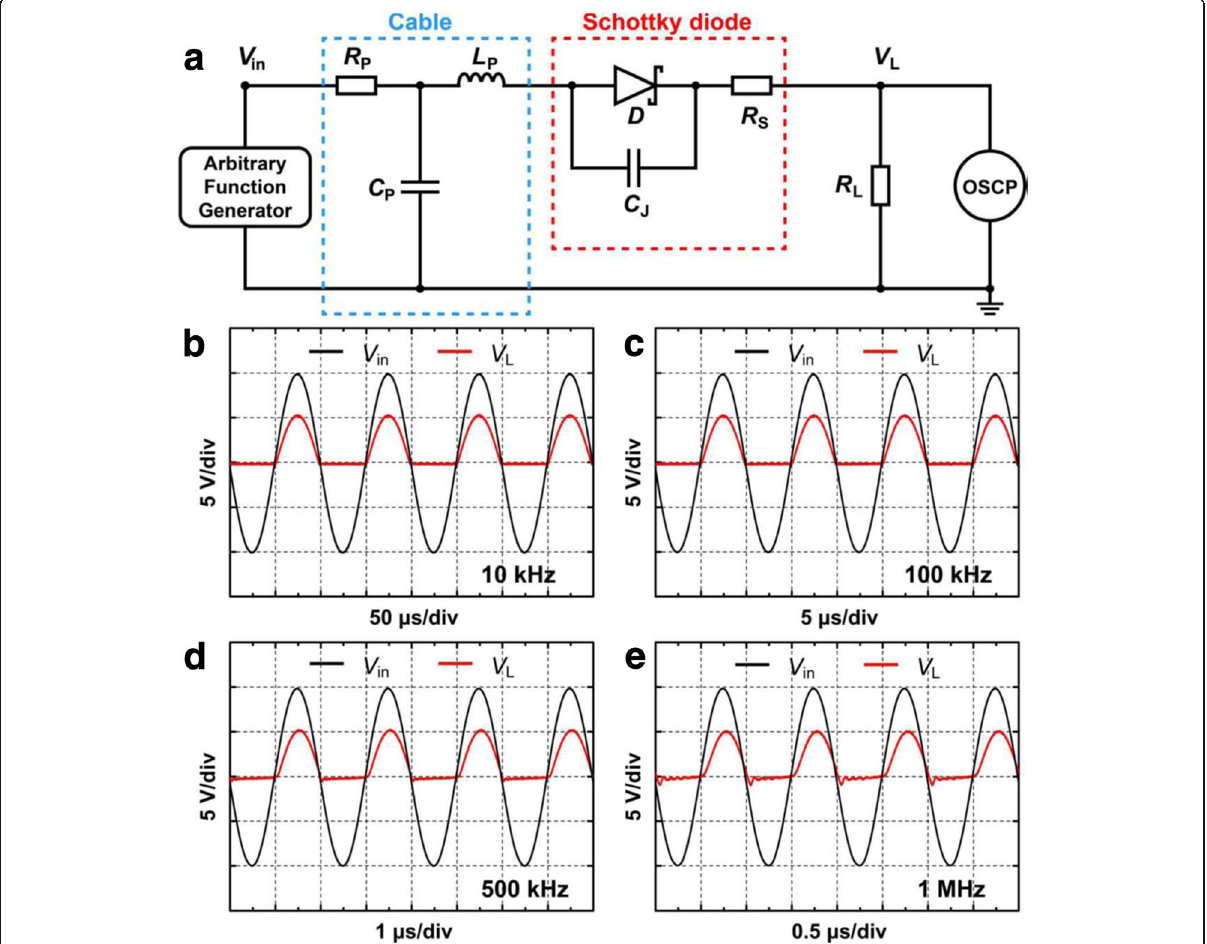
Fig. 12 a Rectification circuit. b – e Rectifying effect of Pt/Ga 2 O 3 SBD on the AC signals under frequency of 10 kHz, 100 kHz, 500 kHz, and 1 MHz. Reprinted from ref.